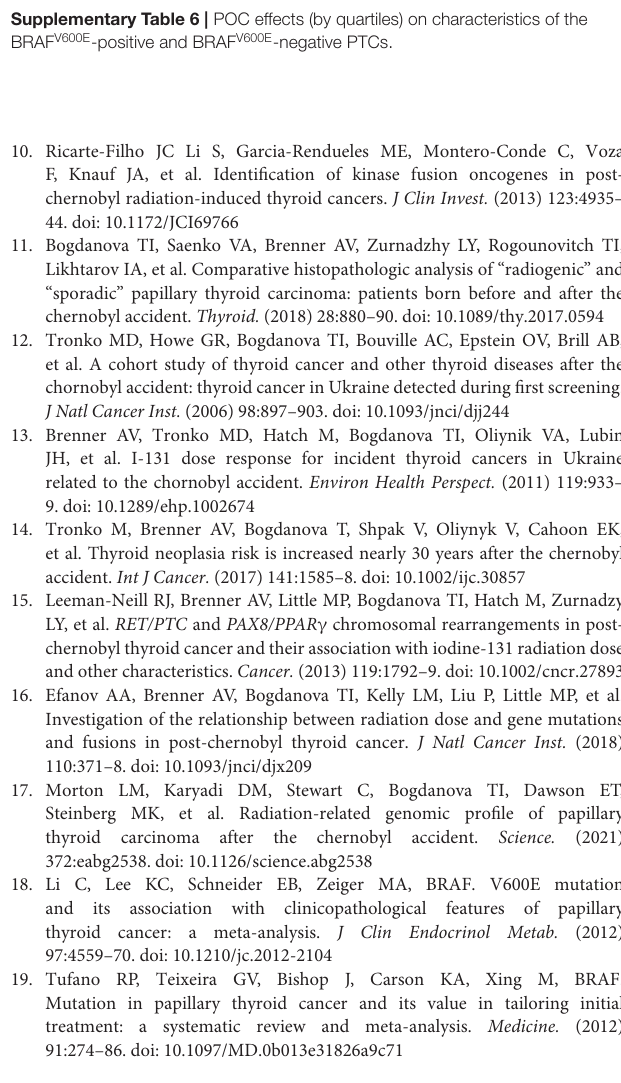
Supplementary Table 5 | Comparative characteristics of the BRAF V600E -positive vs. BRAF V600E -negative PTCs in the groups matched 1:1 by age at operation ( ± 2